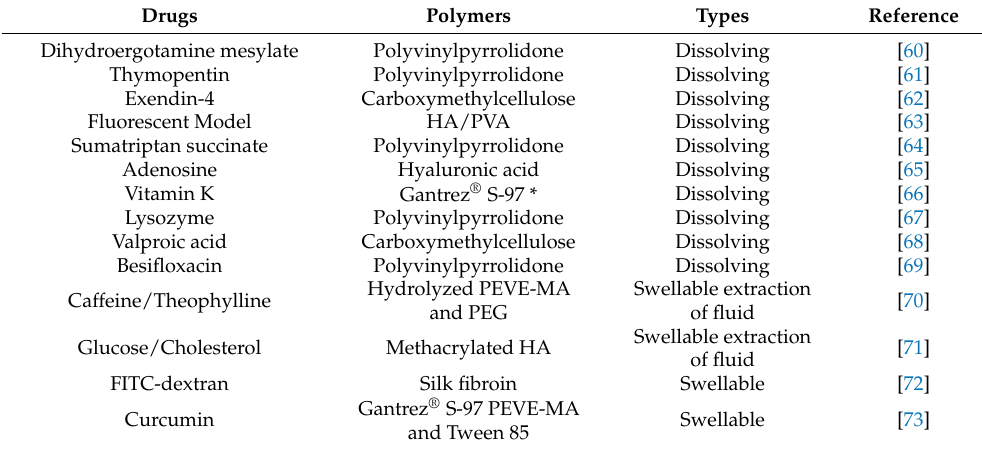
Table 4. Dissolvable/swellable microneedle devices. Adapted with permission from [59].